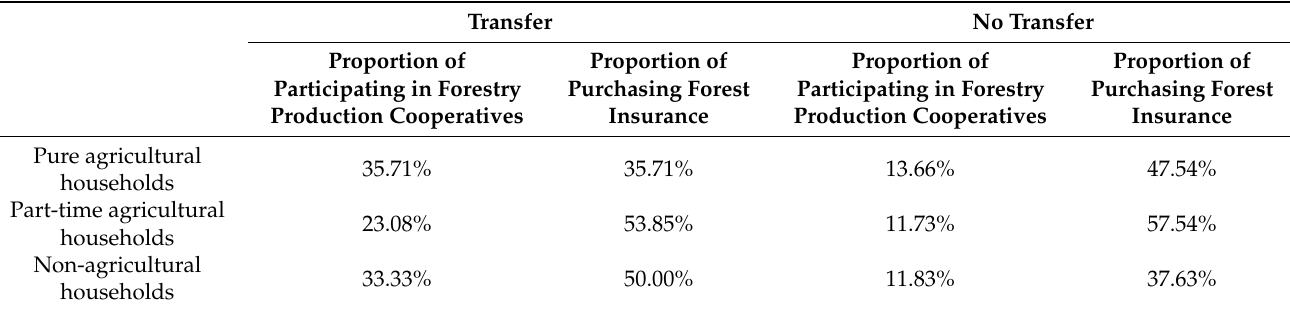
Table 6. Forestland transfer and agricultural household’s